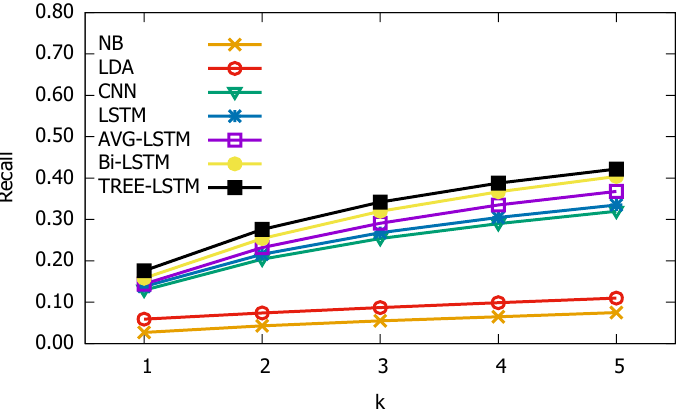
Figure 17. Recall values with recommended hashtags range from 1 to 5 in Zhihu dataset.